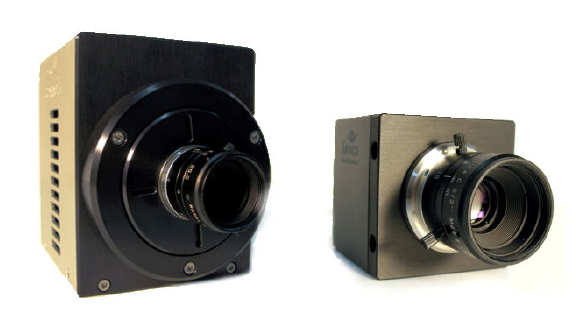
Figure 1. Xeva-4246, and XEVA XS-1.7.320 Both sensors have 320-256Px InGaAs arrays with 30 µ m